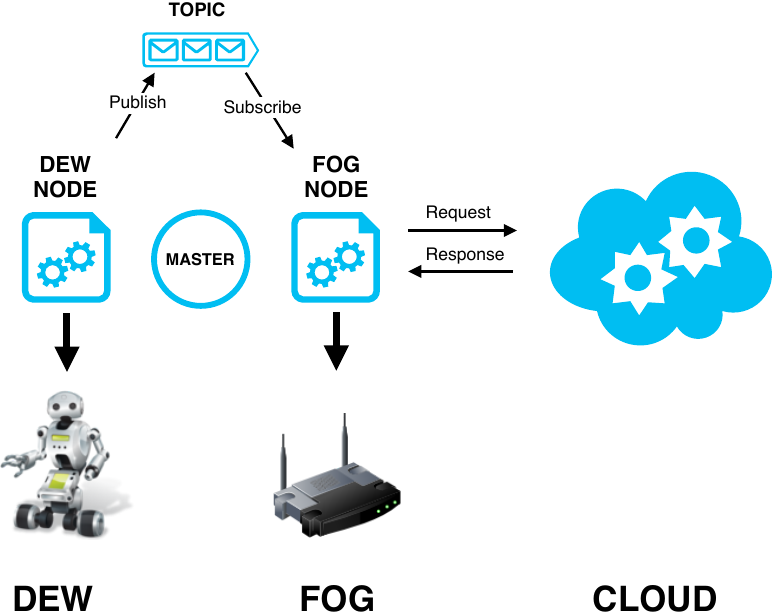
Figure 2. General three-tier architecture of our Dew Robotics Platform based on